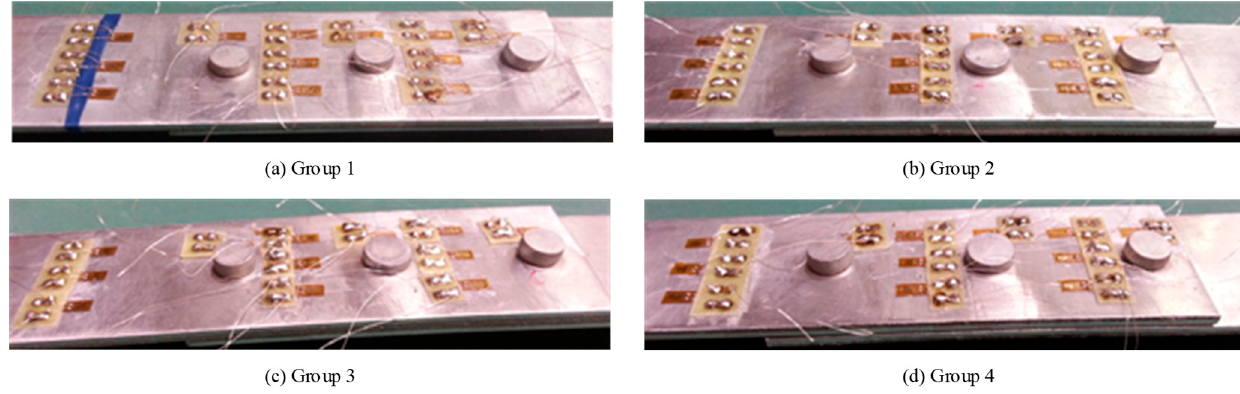
Figure 7. Experiment of riveted lap joint deformations after riveting. ( a ) Group 1. ( b ) Group 2. ( c ) Group 3. ( d ) Group 4.